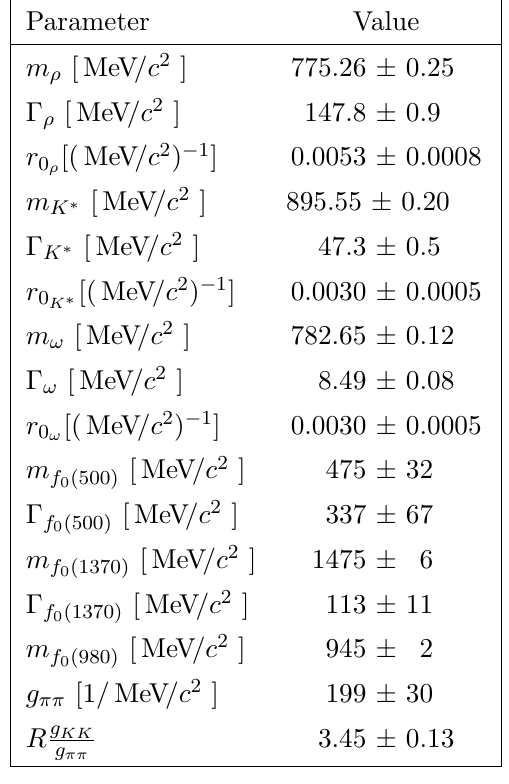
Table 7. Central values of the mass-propagator parameters and their uncertainties, used to es- timate the corresponding systematic uncertainties. The values of the parameters used to describe the f 0 (500) and f 0 (1370) resonances were taken from ref. [52] and the rest, from ref.